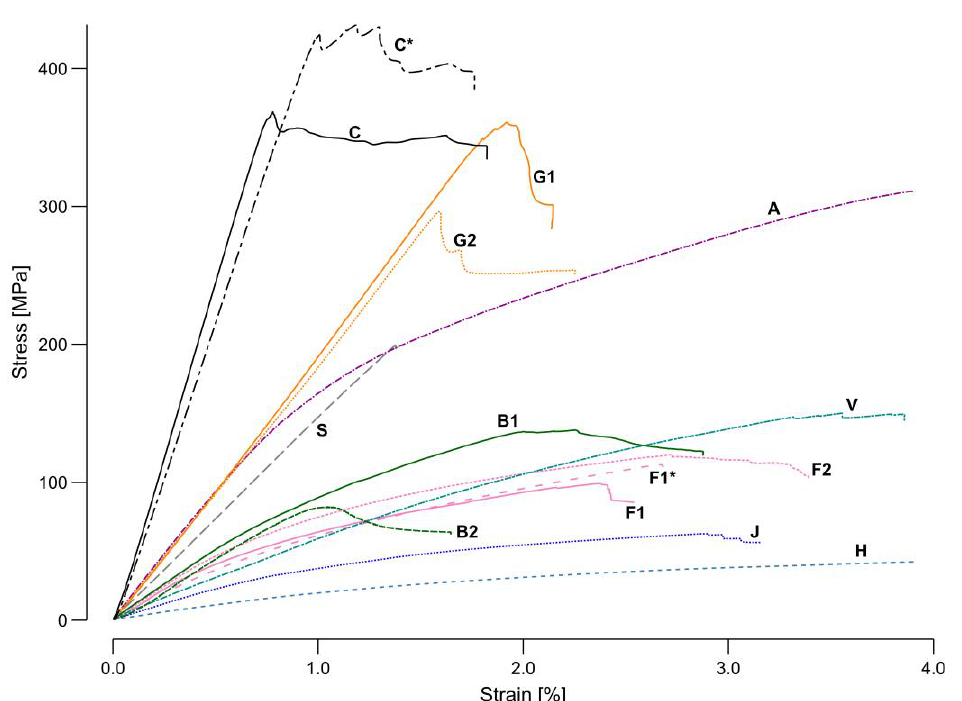
Figure 11. Comparative scaled stress – strain diagram of the four-point bending tests by selecting a representative graph of each sample. C — carbon, C* — carbon with petroleum-based resin, G1 — E- glass, G2 — S-glass, B1 — basalt, type 1, B2 — basalt, type 2, A — aramid, S — stainless steel, V — viscose, F1 — flax tape, F1* — flax tape with petroleum-based resin, F2 — flax yarn, H — hemp, J — jute.